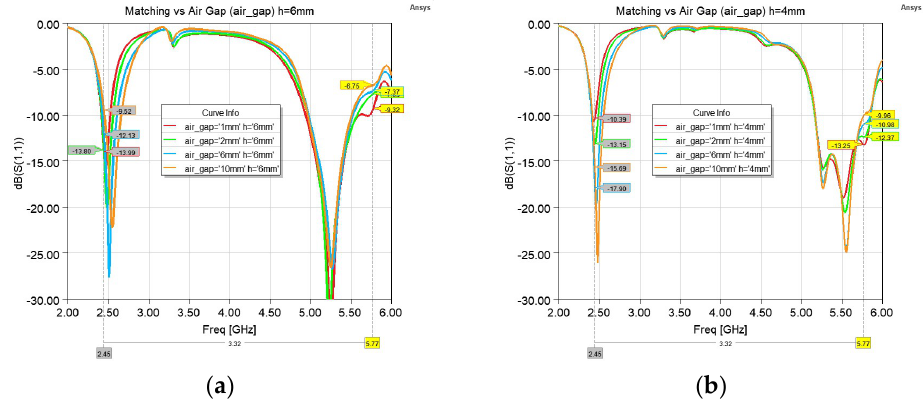
Figure 3. Reflection coefficient (S11) variation with 𝑎𝑖𝑟_𝑔𝑎𝑝 size for ( a ) Substrate thickness of 6 mm; ( b ) Substrate thickness of 4 mm.